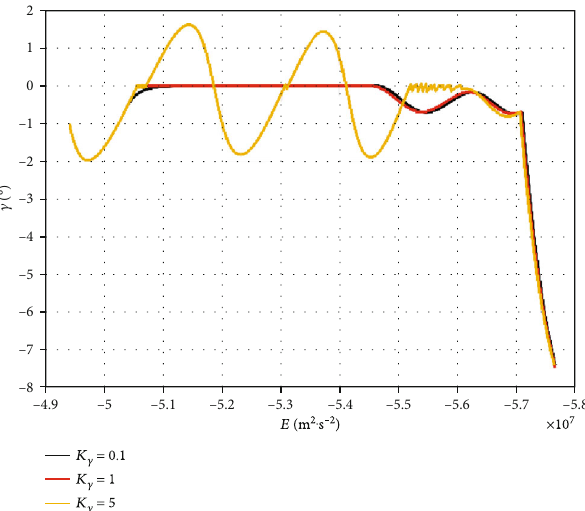
Figure 6: E ff ect of di ff erent K γ on the equilibrium glide condition.